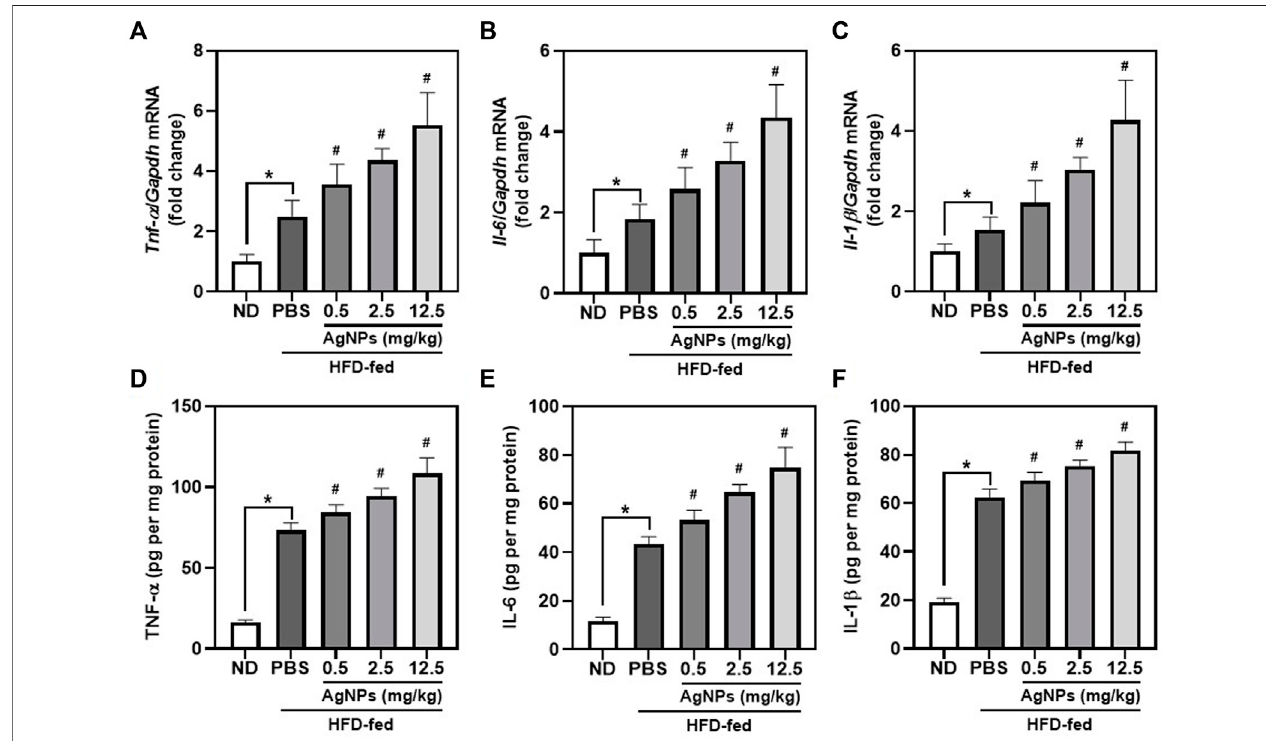
FIGURE 4 | AgNPs worsen liver in fl ammation in mice with NAFLD induced by HFD. The expression of hepatic proin fl ammatory genes including Tnf- α (A) , Il-6 (B) , and Il-1 β (C) in ND-fed mice and HFD-fed mice treated with AgNPs. Gene expression was normalized to Gapdh. The contents of proin fl ammatory cytokines including TNF- α (D) , IL-6 (E) , and IL-1 β (F) in the liver of ND-fed mice and HFD-fed mice treated with AgNPs were measured by ELISA. * p < 0.05 vs. ND-fed group; # p < 0.05 vs. HFD-treated